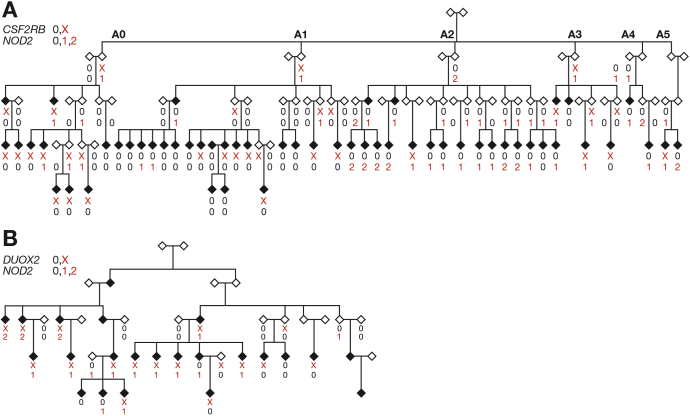
Pedigrees showing all affected individuals (filled symbols) and their connecting relatives in (A) Family A and (B) Family B. All individuals are been shown as diamonds regardless of sex. (A) Subfamilies have been labeled A0–A5. The genotypes of a frameshift mutation in CSF2RB p.S709LX22 in A, a missense variant in DUOX2 p.P303R in B (0 wild type, X heterozygous) and a composite of the 3 NOD2 variants examined (p.G908R, p.R702W, p.L1007fsinsC) (0, wild type; 1, heterozygous; or 2, homozygous or compound heterozygous) are shown where available.